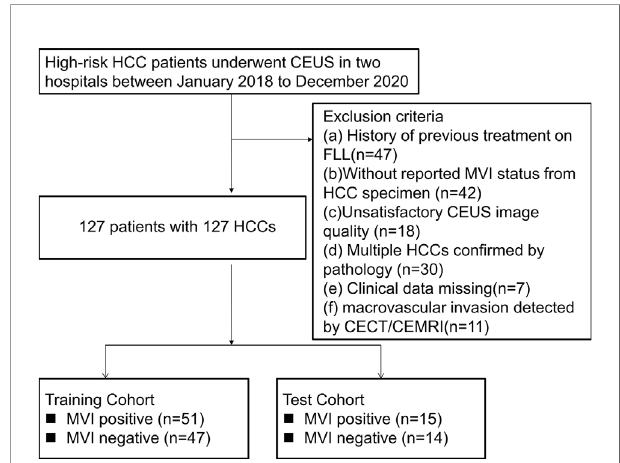
FIGURE 1 | Flowchart of patient selection. HCC, hepatocellular carcinoma; MVI, microvascular invasion; CEUS; contrast enhanced ultrasound; CECT, contrast enhanced computed tomography; CEMRI, contrast enhanced magnetic resonance imaging; FLL, focal liver